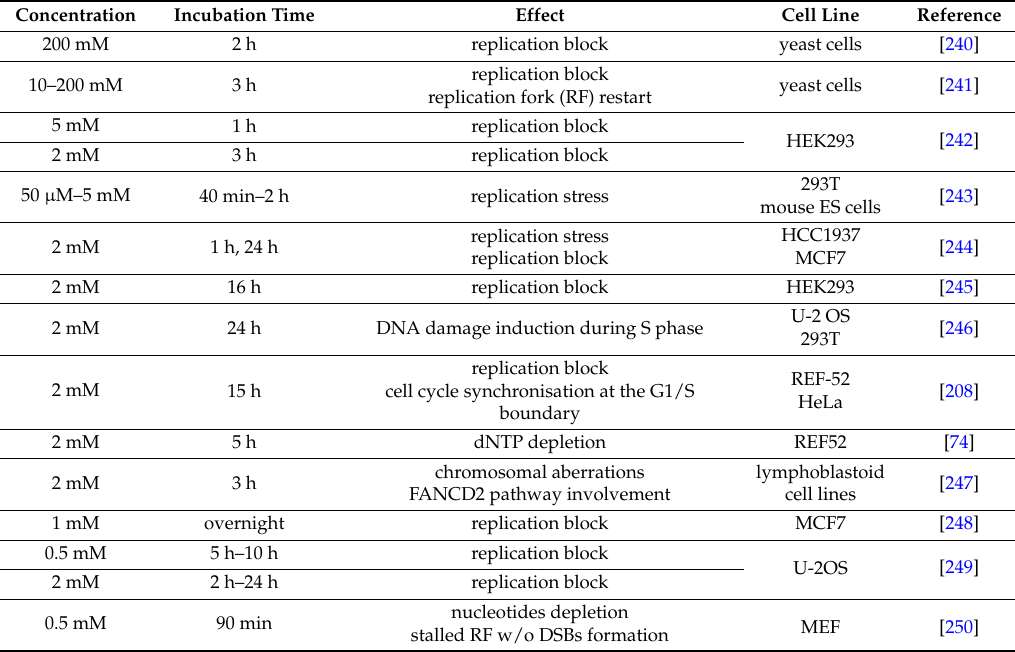
Table 3. Effects of various hydroxyurea treatments in